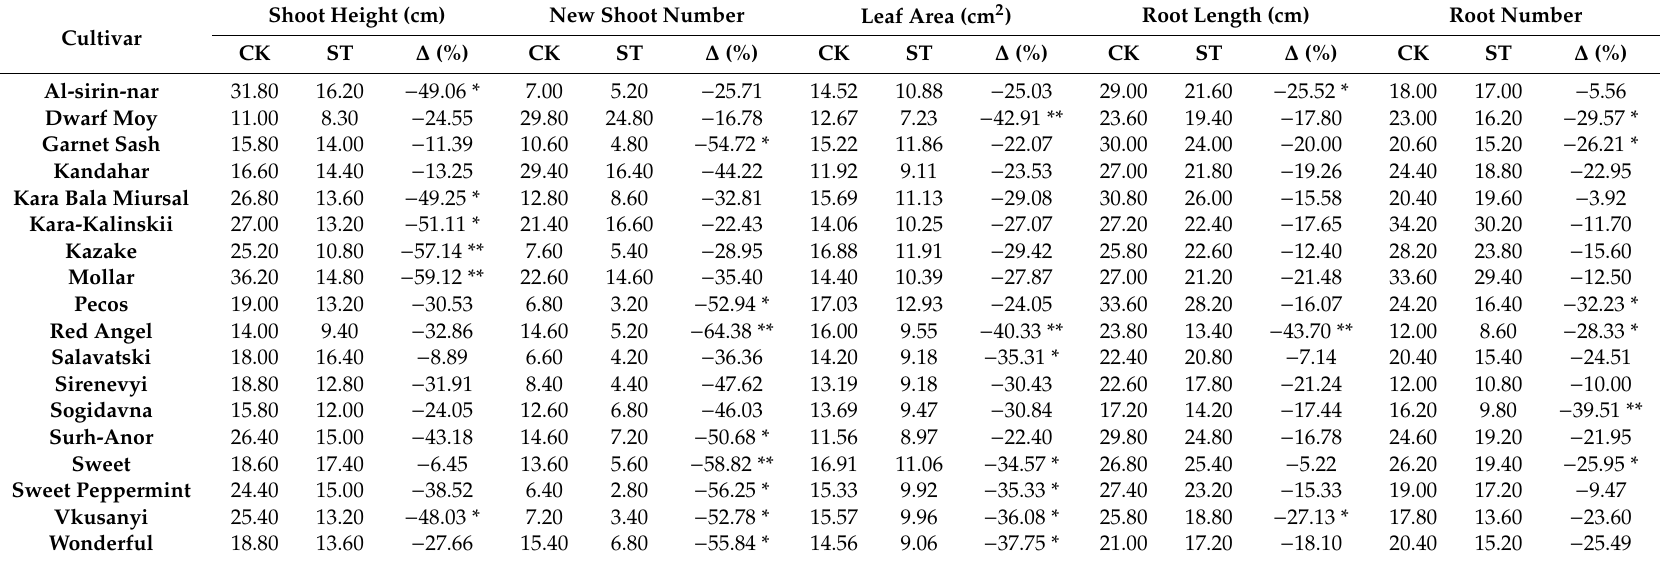
Table 2. E ff ects of NaCl stress on shoot height, new shoot number, leaf area, root length, and root number of pomegranate roots, stems and leaves.